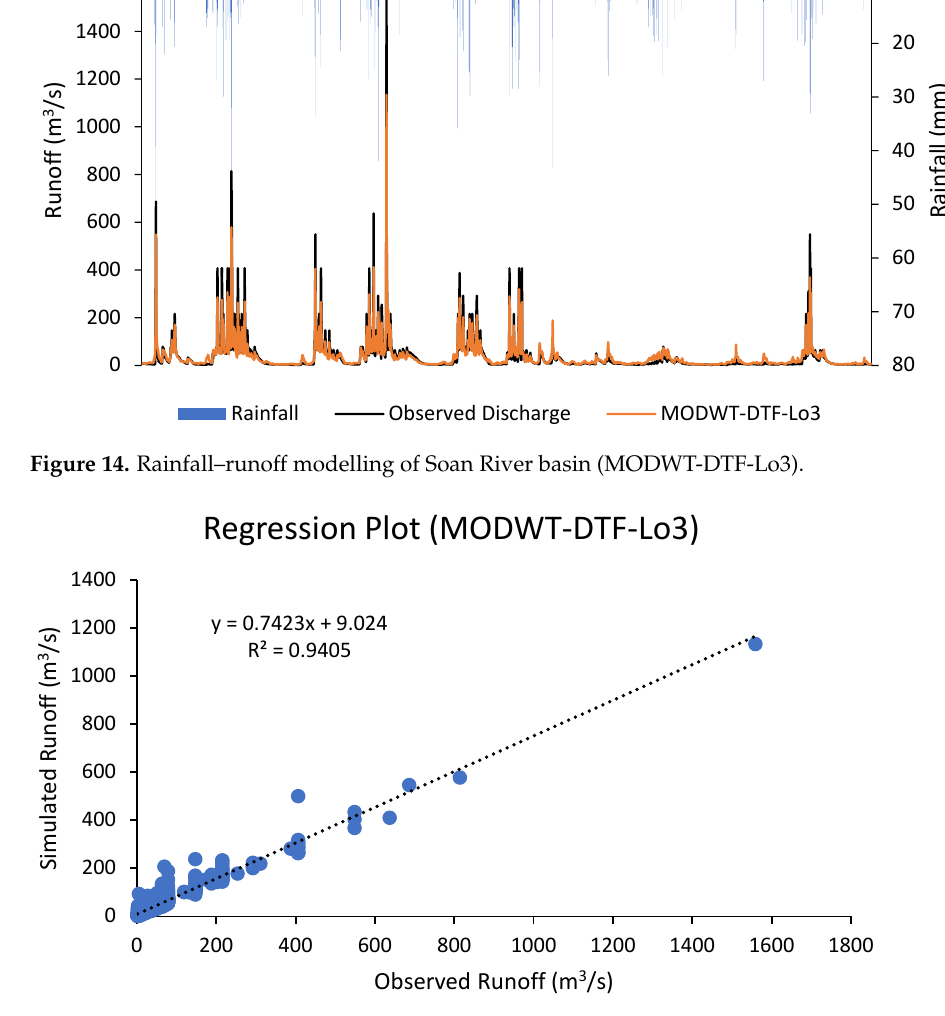
Figure 15. Regression plot (MODWT-DTF-Lo3).